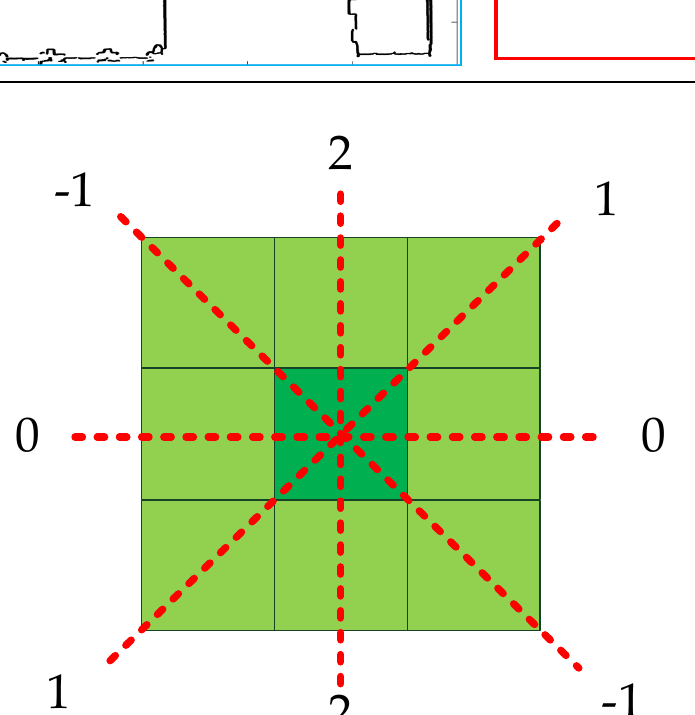
Figure 12. The slope of the nearest neighbor. The slope is given four values: 0, 1, − 1, 2.